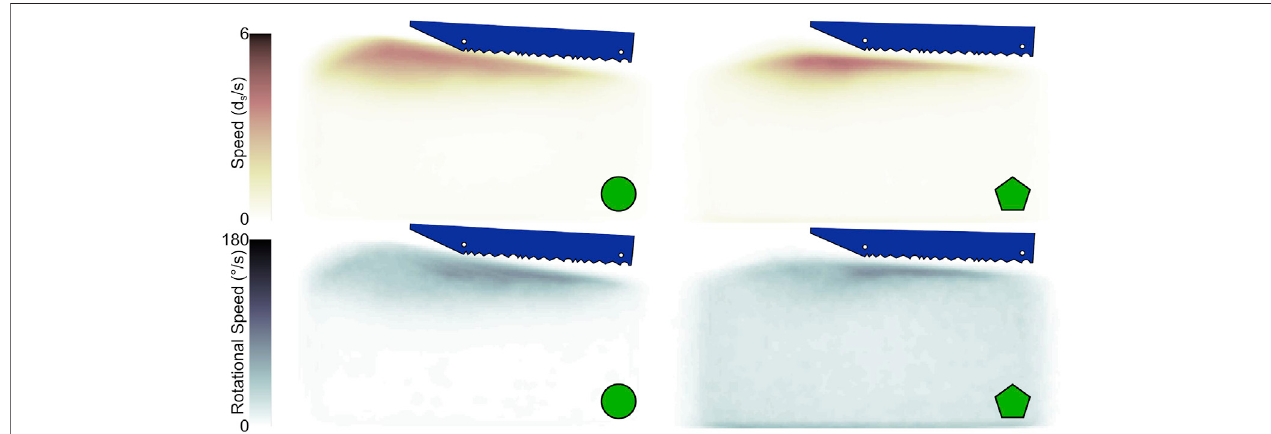
FIGURE 11 | Average speed and rotational speed fl ow fi elds during slip events for disks (left) and pentagons (right). The baseline noise for rotational speed of pentagonsissigni fi cantlygreaterthanthatofdisks duetodifferencesin themethods usedtotrack orientations ofdisks andangulargrains. Aschematic ofthesliderhas been drawn near each fl ow fi eld for reference.